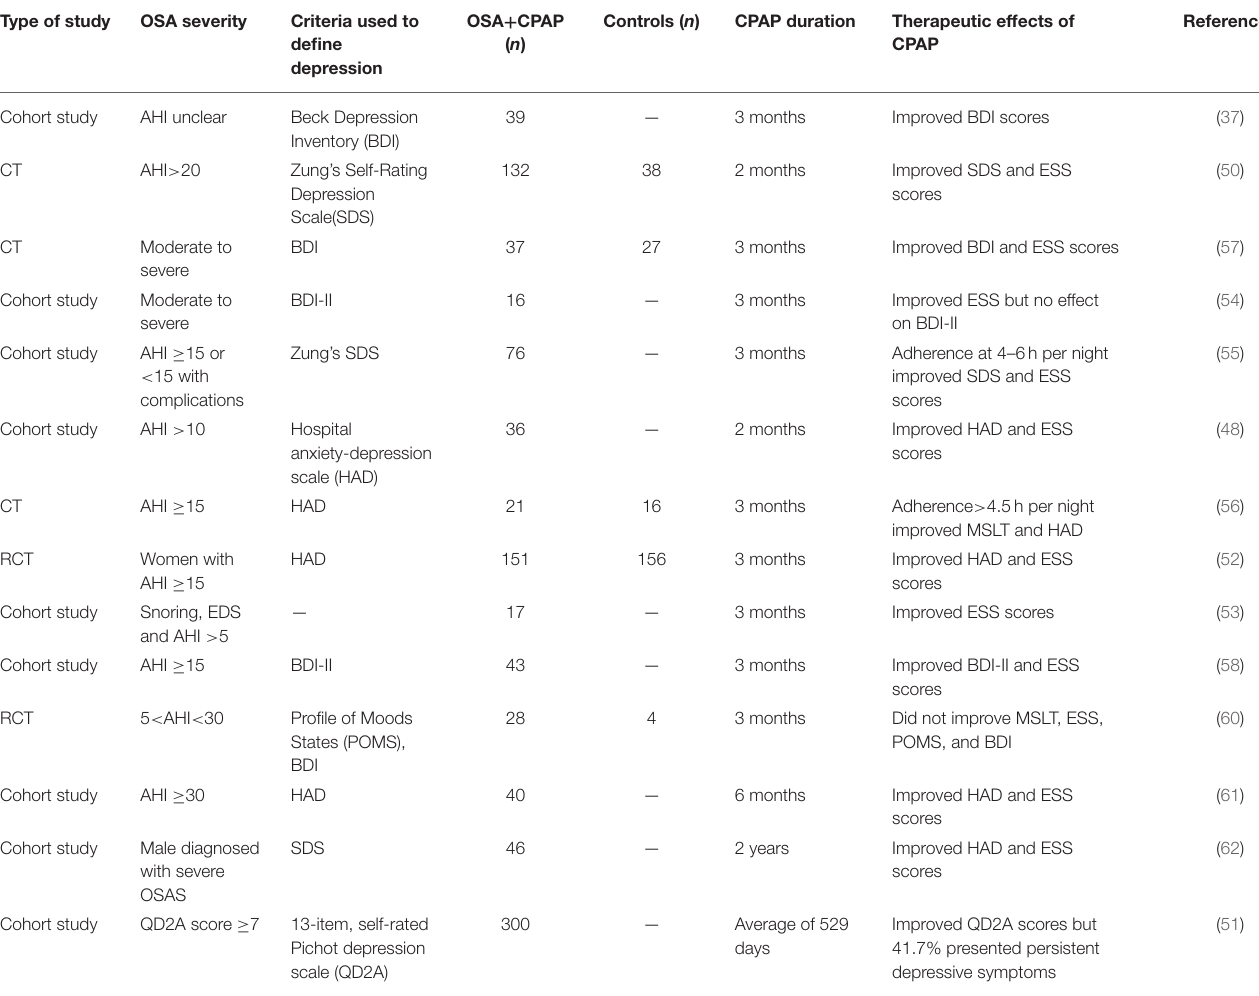
TABLE 1 | CPAP and its therapeutic effects on EDS and